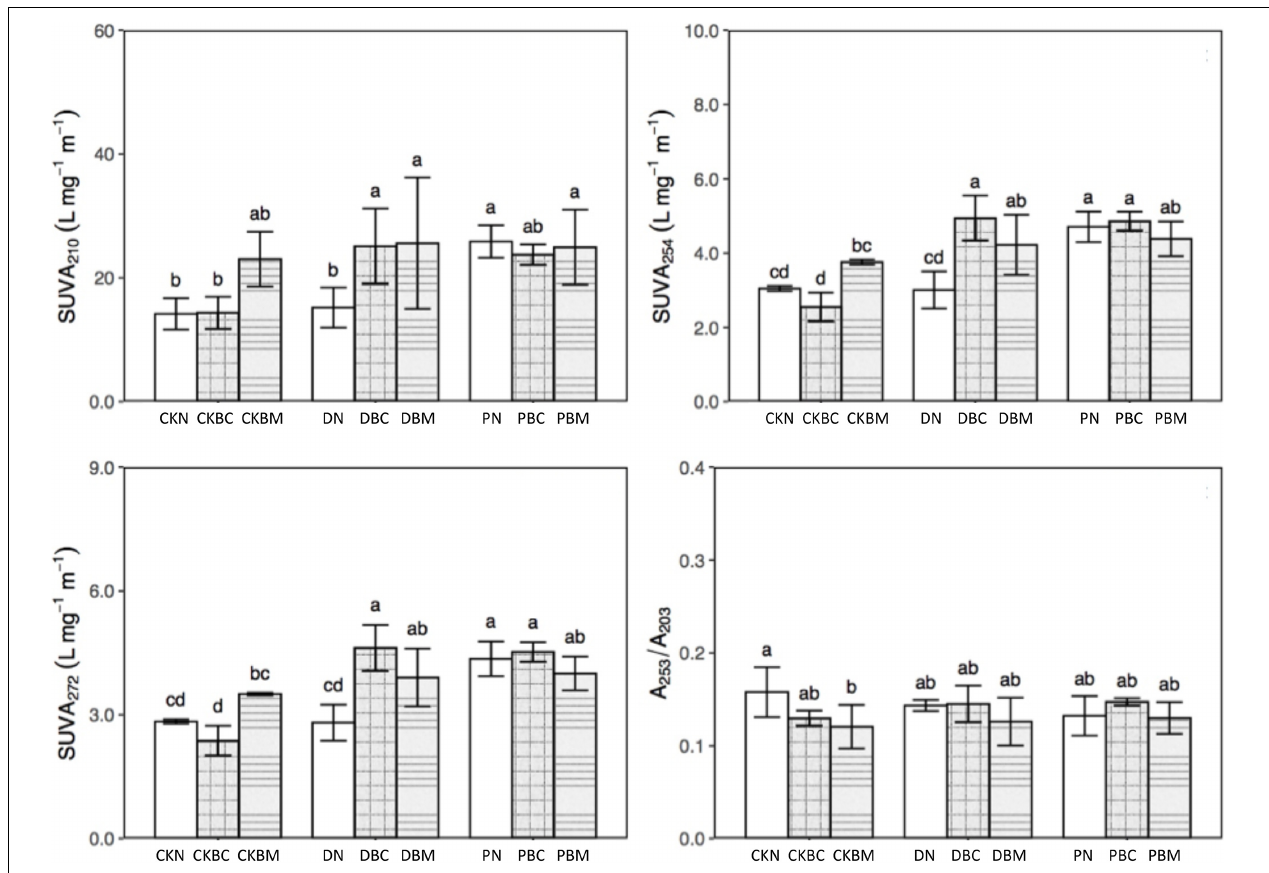
FIGURE 3 | Specific ultraviolet absorbance (SUVA) at different wavelengths: SUVA 210 , SUVA 254 , SUVA 272 , and A 253 /A 203 of different treatments. SUVA 210 means amines, SUVA 254 and SUVA 272 mean aromatic substances, and A 253 /A 203 represent aromatic ring substituents.